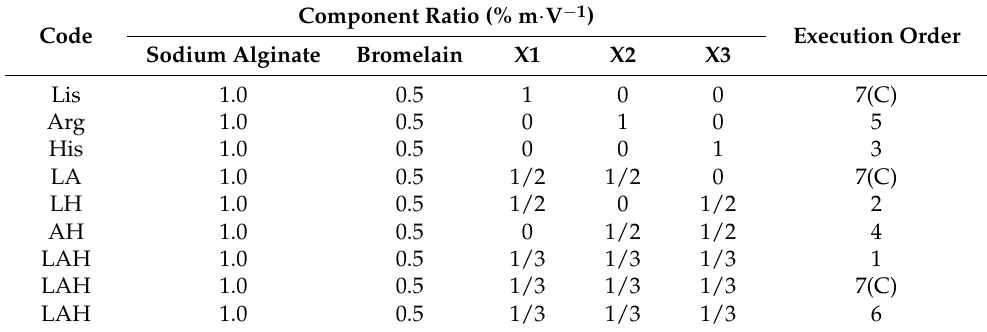
Table 1. A simplex-centroid design with ratios of l-lysine (X1), l-arginine (X2), and l-histidine (X3).